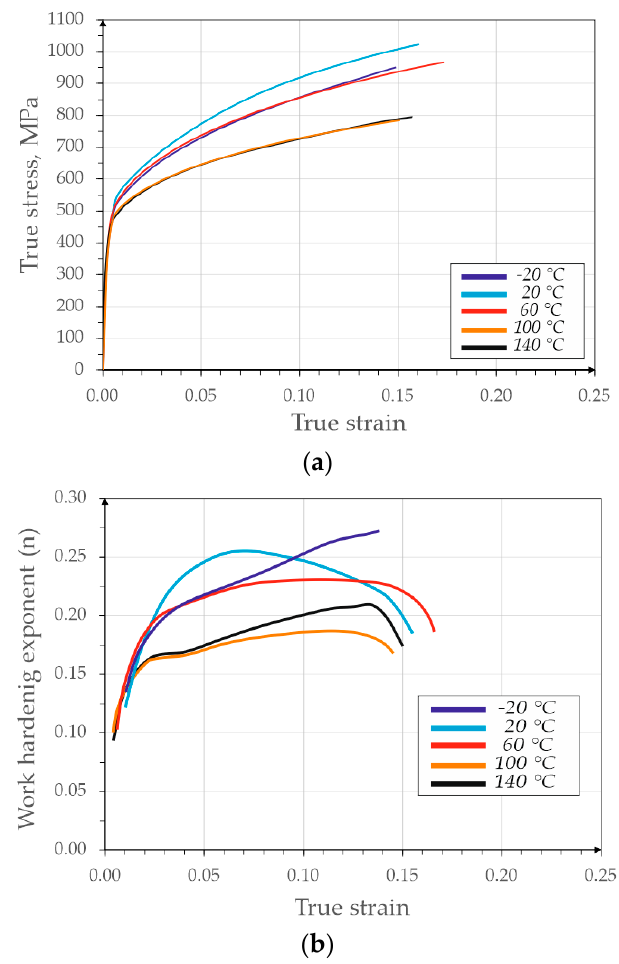
Figure 3. Mechanical properties of steel deformed at different temperatures: ( a ) true stress–strain curves and ( b ) work hardening exponent ( n ) as a function of true strain.